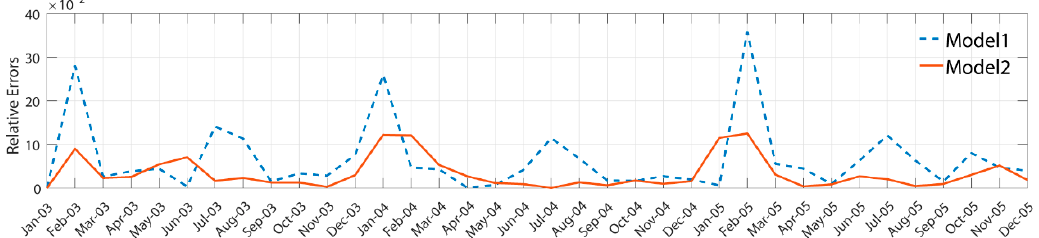
Figure 4. Comparison of relative error of both models.